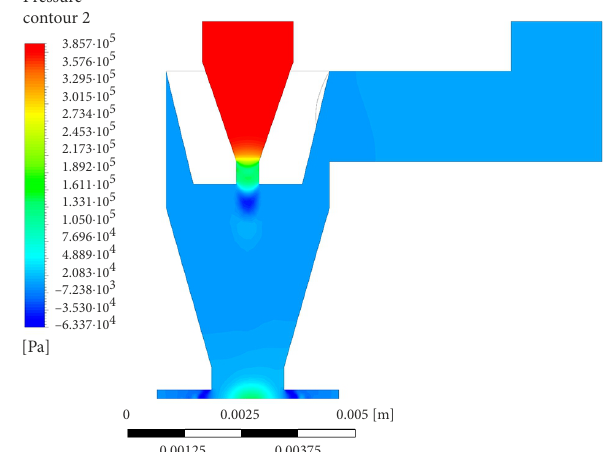
Figure 11. Distribution of pressure along the cross-section of the measuring